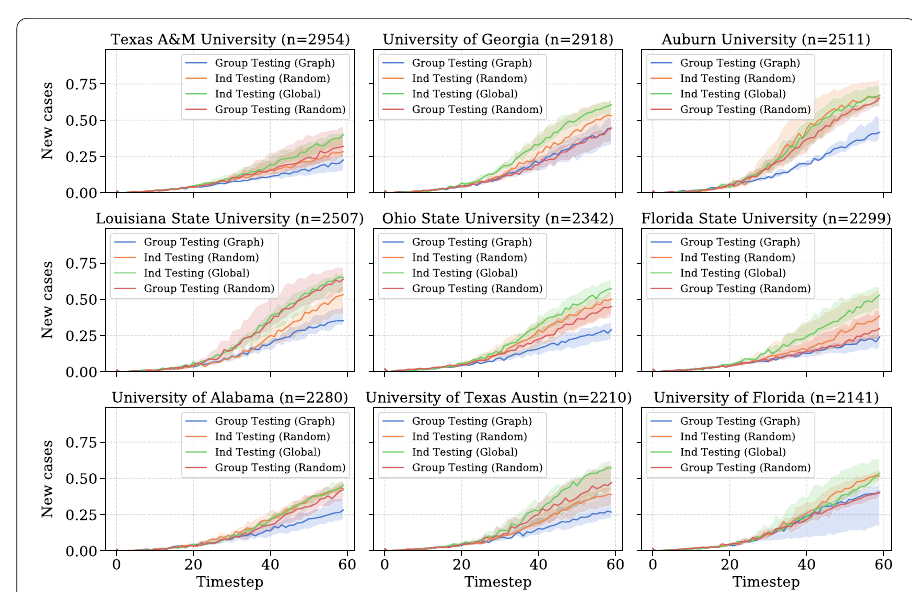
Fig. 2 Case counts over time for the nine colleges with the largest device_counts (see “Appendix” for definition). The line is the median case count and the shaded areas represent the interquartile range. For all nine plots, q = 0.15 and δ =